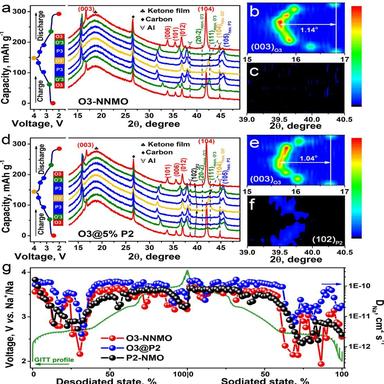
The structural evolution and Na+ diffusion kinetics of prepared cathodes during cycling. Ex situ XRD patterns of (a–c) O3-NNMO and (d–f) O3@5% P2 cathodes at different sodiation/desodiation states collected in the initial cycle (all the electrodes were protected with ketone films to avoid exposure to air). (g) Voltage profile and calculated DNa+ values based on GITT measurements.